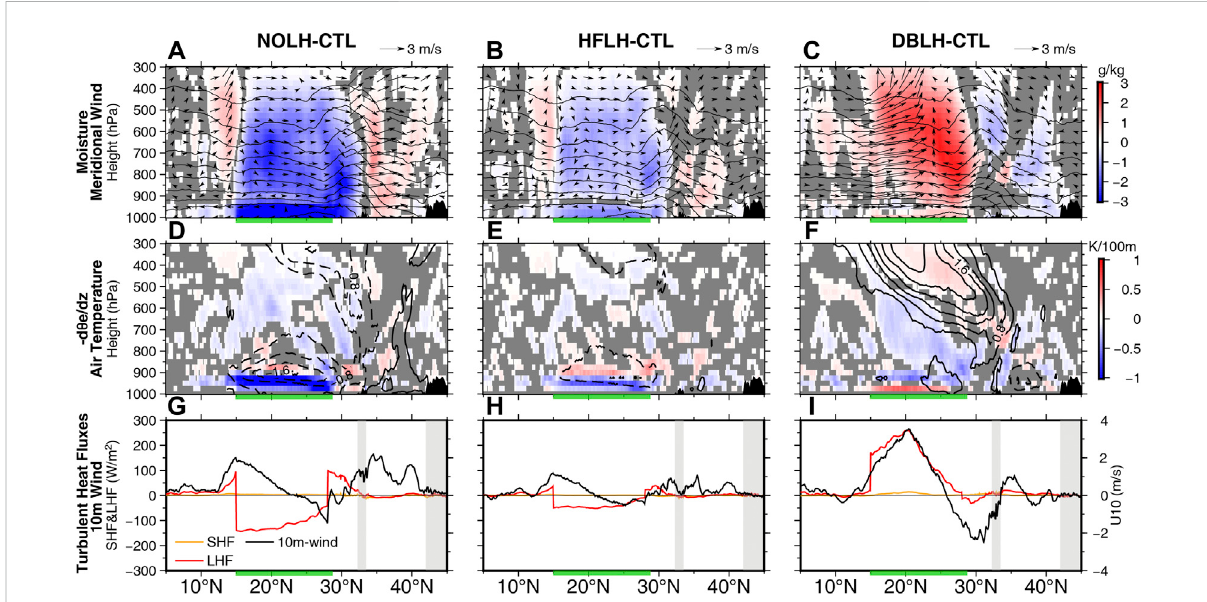
FIGURE 4 Cross-sectional differences between sensitivity experiments and the CTL run along 130 ° E: (A – C) speci fi c humidity (q, color shading; contours represent q of the CTL run) and meridional wind (vectors; w is ampli fi ed 50 times for visualization), (D – F) vertical gradient of the equivalent potential temperature( − d θ e / dz ,colorshadingandpositivemeansunstable)andtemperature(contour),and (G – I) surfaceturbulentheat fl uxesand10 m-wind speed.In (A – F) ,valuesbelowthe95%con fi dencelevelweremaskedoutbasedonStudent ’ st-test,andcontourswereplottedevery2 g/kgand 0.4 K, respectively. Green shading in all panels represents the subtropical WP region, and light-gray shadings in (G – I) represent the land